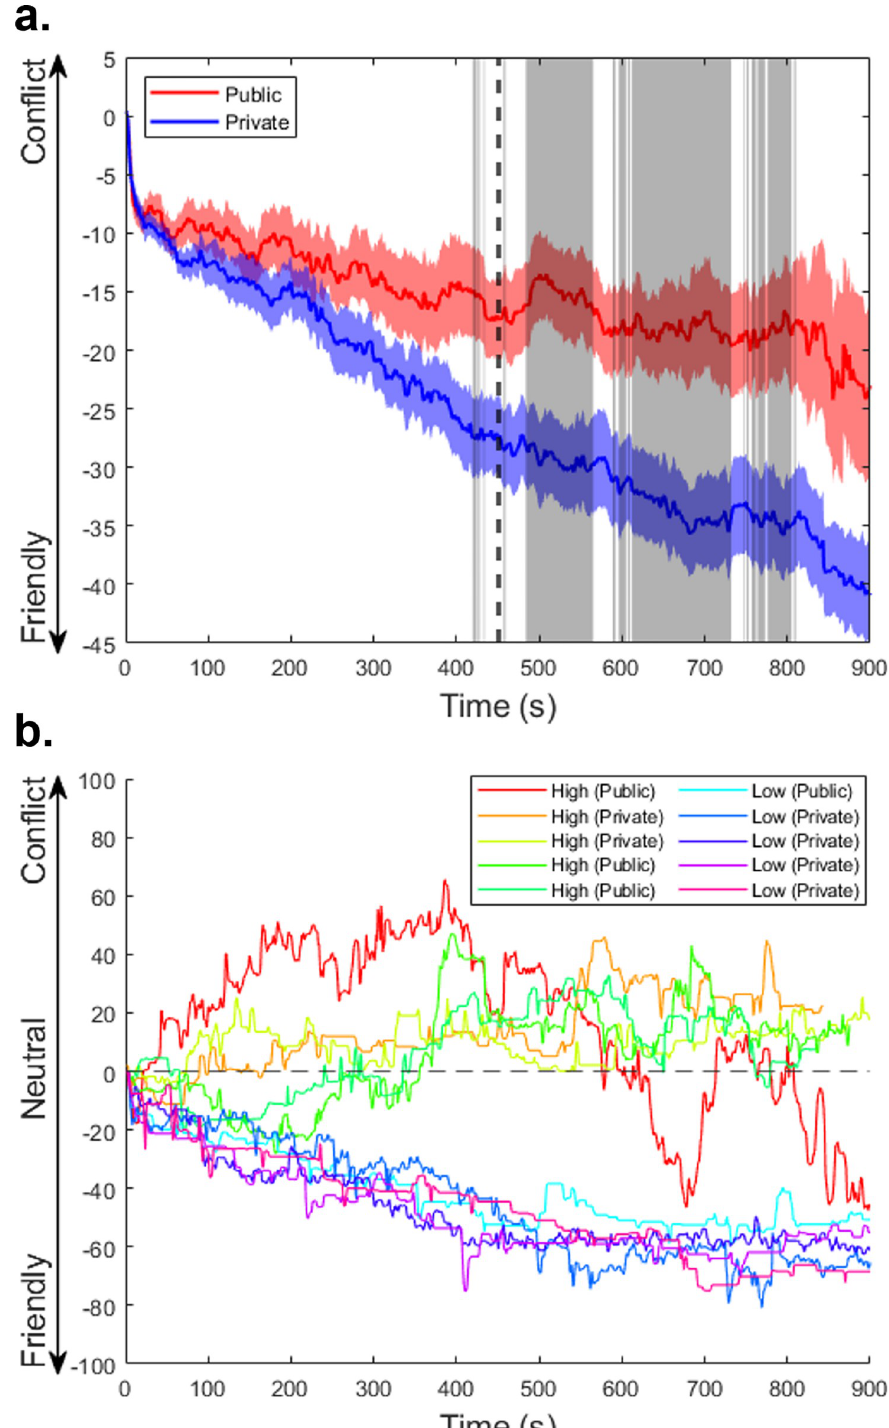
Fig 4. Coder-rated conflict time courses of conversations. Note . a. Mean time courses of coder-rated conflict are shown for both the public and private conditions. The gray shaded regions show timepoints where the difference between conditions is significant. These regions are mostly confined to the latter half of conversations, with the first major region beginning at 484 seconds. Colored shaded areas represent +- 1 SE across conversations. b. Top 5 and bottom 5 conversations’ time courses as ranked by coder-rated conflict. Both public and private conditions are